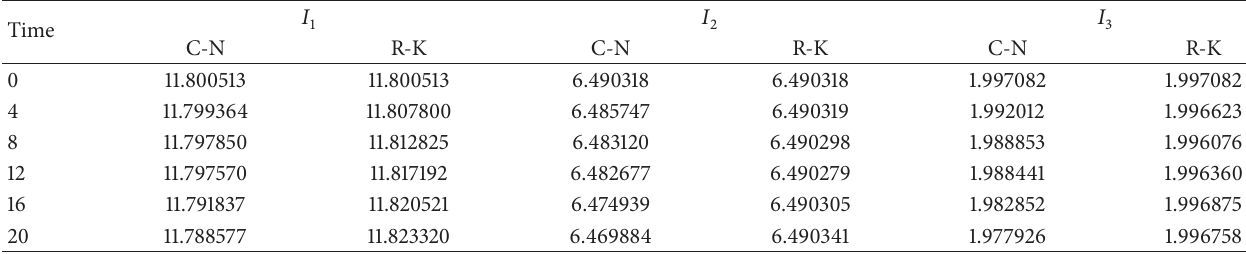
Table 11: Invariants and error norms for three solitary waves, 𝑐 1 = 1 , 𝑐 2 = 0.5 , 𝑐 3 = 0.25 , 𝑥 1 = 10 , 𝑥 2 = 20 , 𝑥 3 = 40 , ℎ = 0.1 , 𝑘 = 0.01 , and 0 ≤ 𝑥 ≤ 100 .